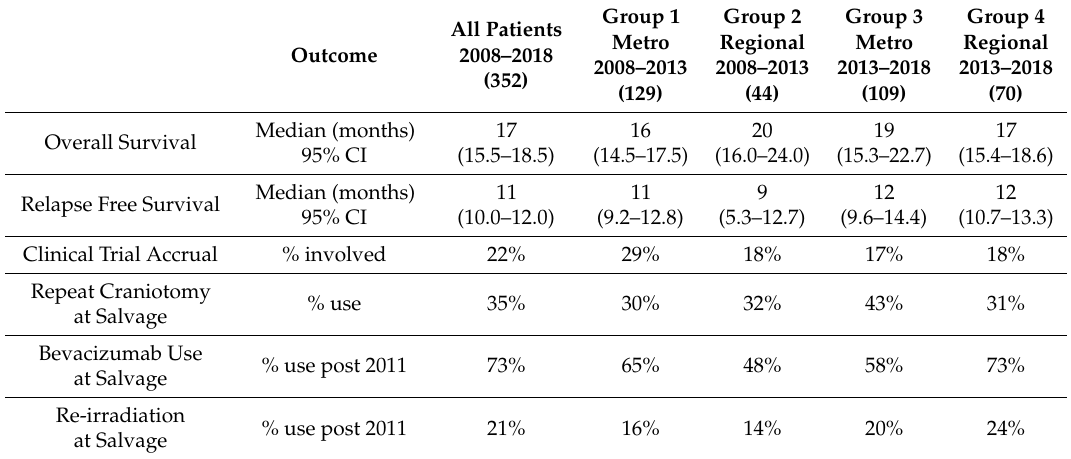
Table 3. Clinical Quality Indicators for geographical Groups